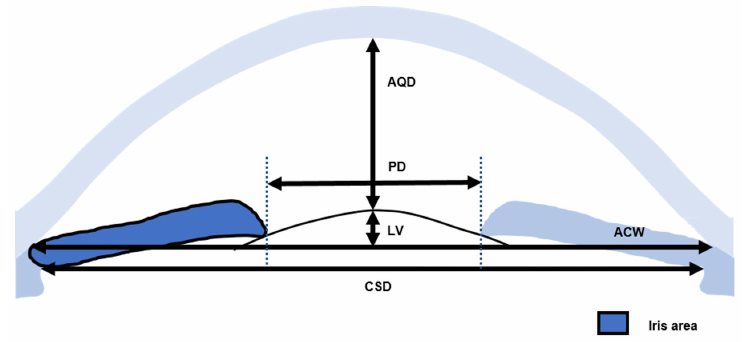
Figure 1. Anterior segment parameters on full-view scans at the nasal-temporal position measured by ultrasound biomicroscopy (UBM). (Illustrator: K.Y.). AQD: the distance between the posterior surface of the central cornea and the anterior surface of the crystalline lens or IOL in the midline of the pupil; PD: the shortest distance between the pupil edges of the iris cross-sections; LV: the perpendicular distance from the anterior pole of the lens to the horizontal line between the SS; ACW: the distance between the two SS’s; iris area: the cumulative cross-sectional area of the full length (from spur to pupil) of the iris; CSD: the distance between the two horizontal diameters for the ciliary sulcus.